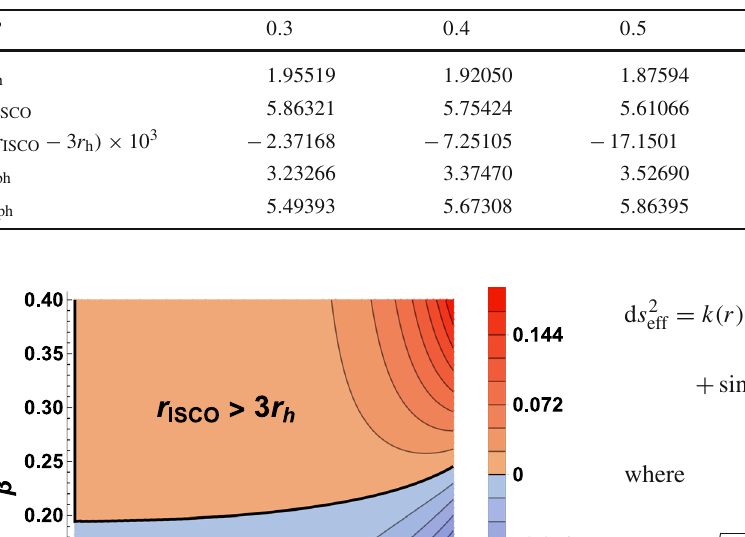
Table 3 Data of r h , r ISCO , r ph , and b ph for different P with fixed M = 1, β = 0 . 1